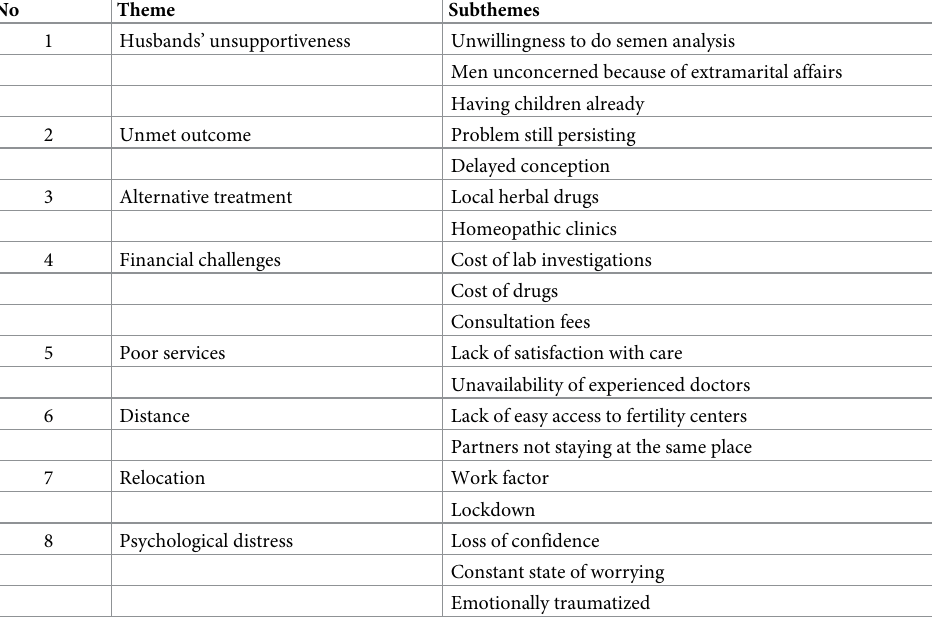
Table 3. Themes and subthemes from infertile